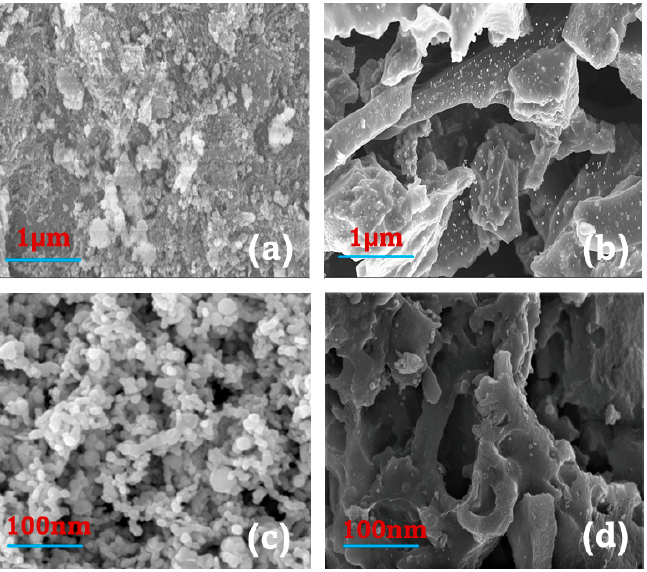
Figure 1. SEM results, ( a , c ) nanoscale zerovalent iron (nZVI); ( b , d ) nanoscale zerovalent ‐ iron ‐ loaded tea biochar